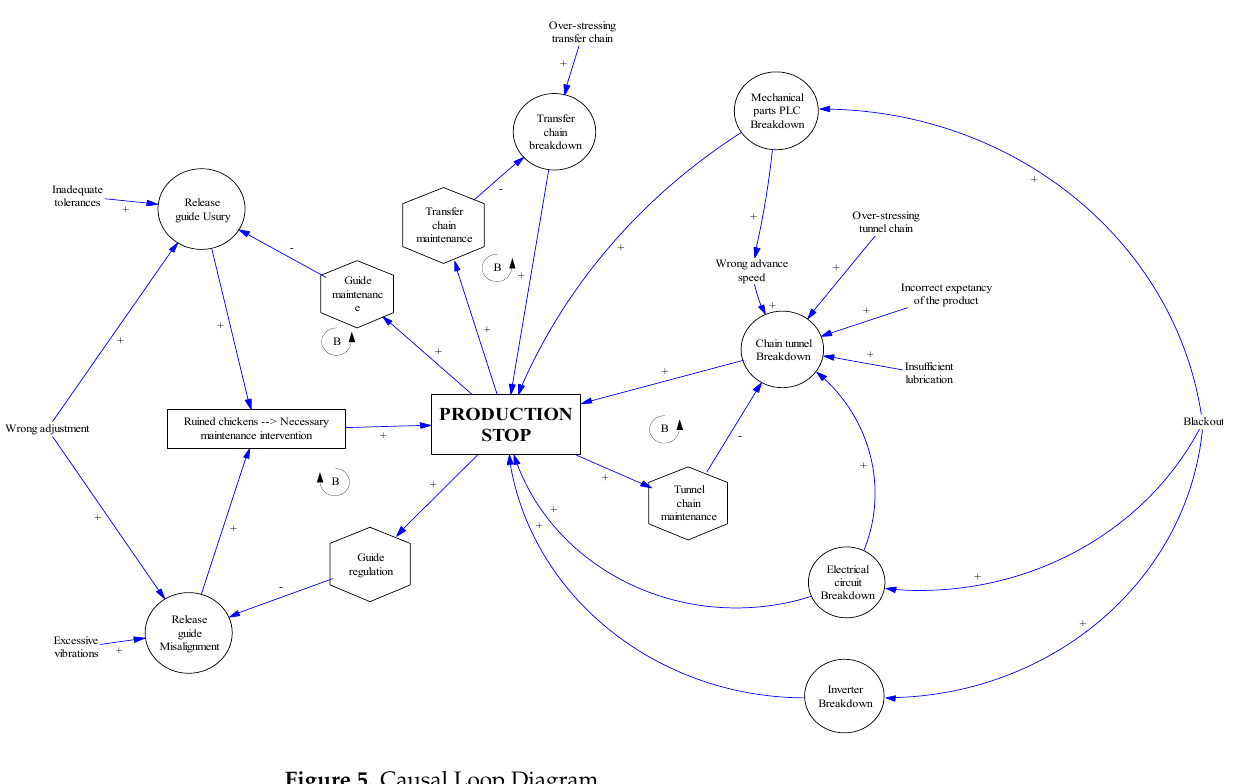
Figure 5. Causal Loop Diagram.